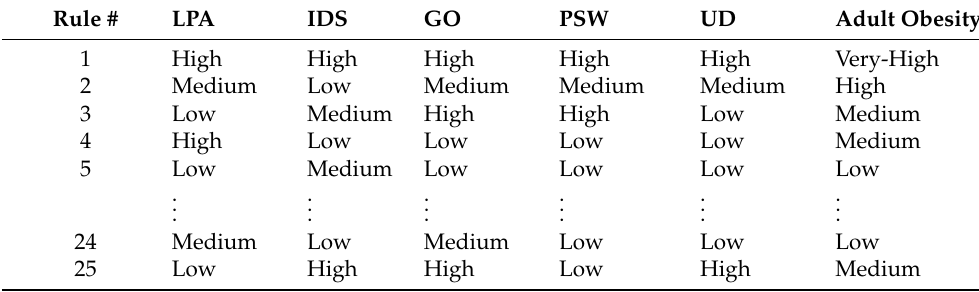
Figure 6. Impact relationship between factors. Table 6. Extracted fuzzy